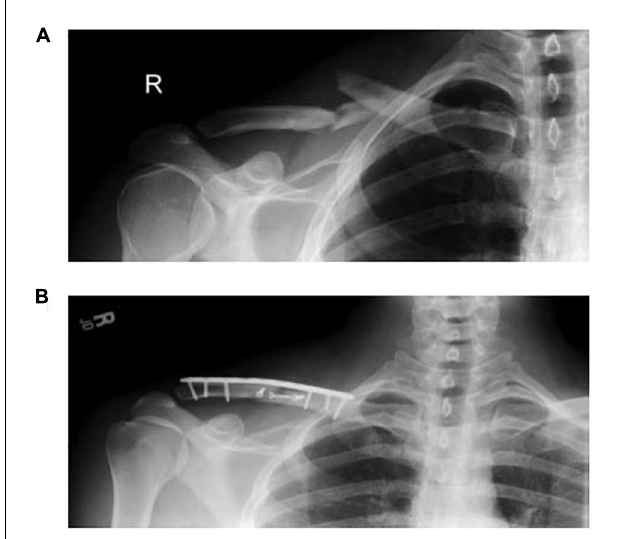
FIGURE 1 | Radiographs of a typical patient treated for a mid-shaft clavicle fracture by open reduction and internal fixation before (A) and after (B)